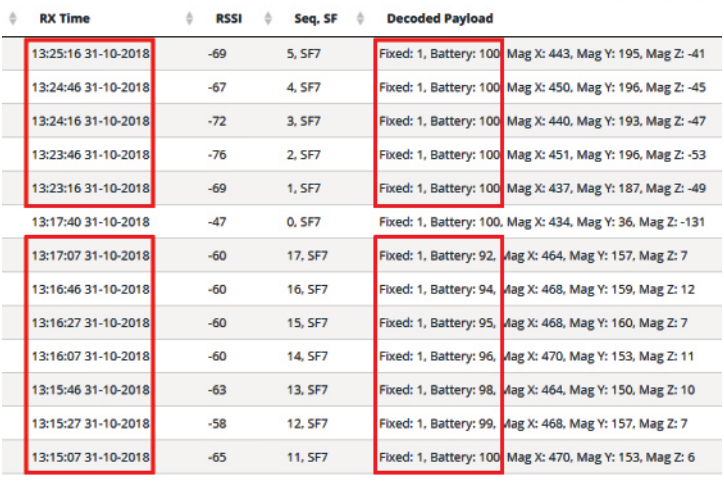
Figure 14. LoRaWAN broadcasting results.